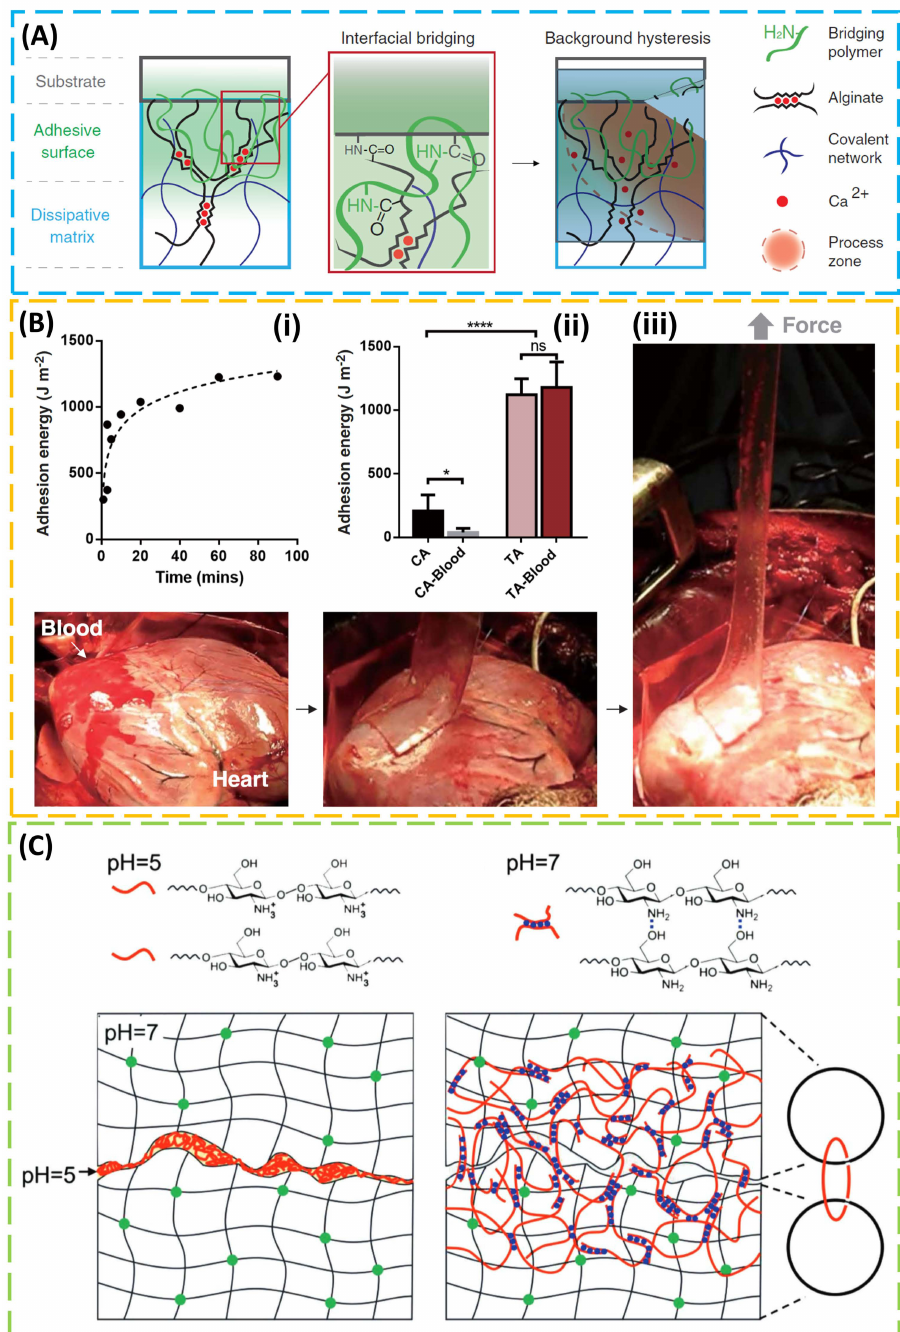
Figure 5. Tough and topological adhesives. ( A ) Tough adhesives (TAs) consist of a dissipative matrix (light-blue square), made of a hydrogel containing both ionically (calcium; red circles) cross-linked and covalently cross-linked polymers (black and blue lines), and an adhesive surface that contains a bridging polymer with primary amines (green lines). The bridging polymer can penetrate into the TA and the substrate (light-green region) to facilitate covalent-bond formation. In the presence of a crack, the process zone (orange area) dissipates significant amounts of energy as ionic bonds between alginate chains and calcium ions break. ( B ) ( i ) Tough adhesives exhibit a rapid increase in adhesion energy to porcine skin over time. ( ii ) Comparing with cyanoacrylate (CA), TAs showed strong adhesion even when the porcine skin was exposed to blood in the in vitro experiment. n = 4–6. ( iii ) The TAs